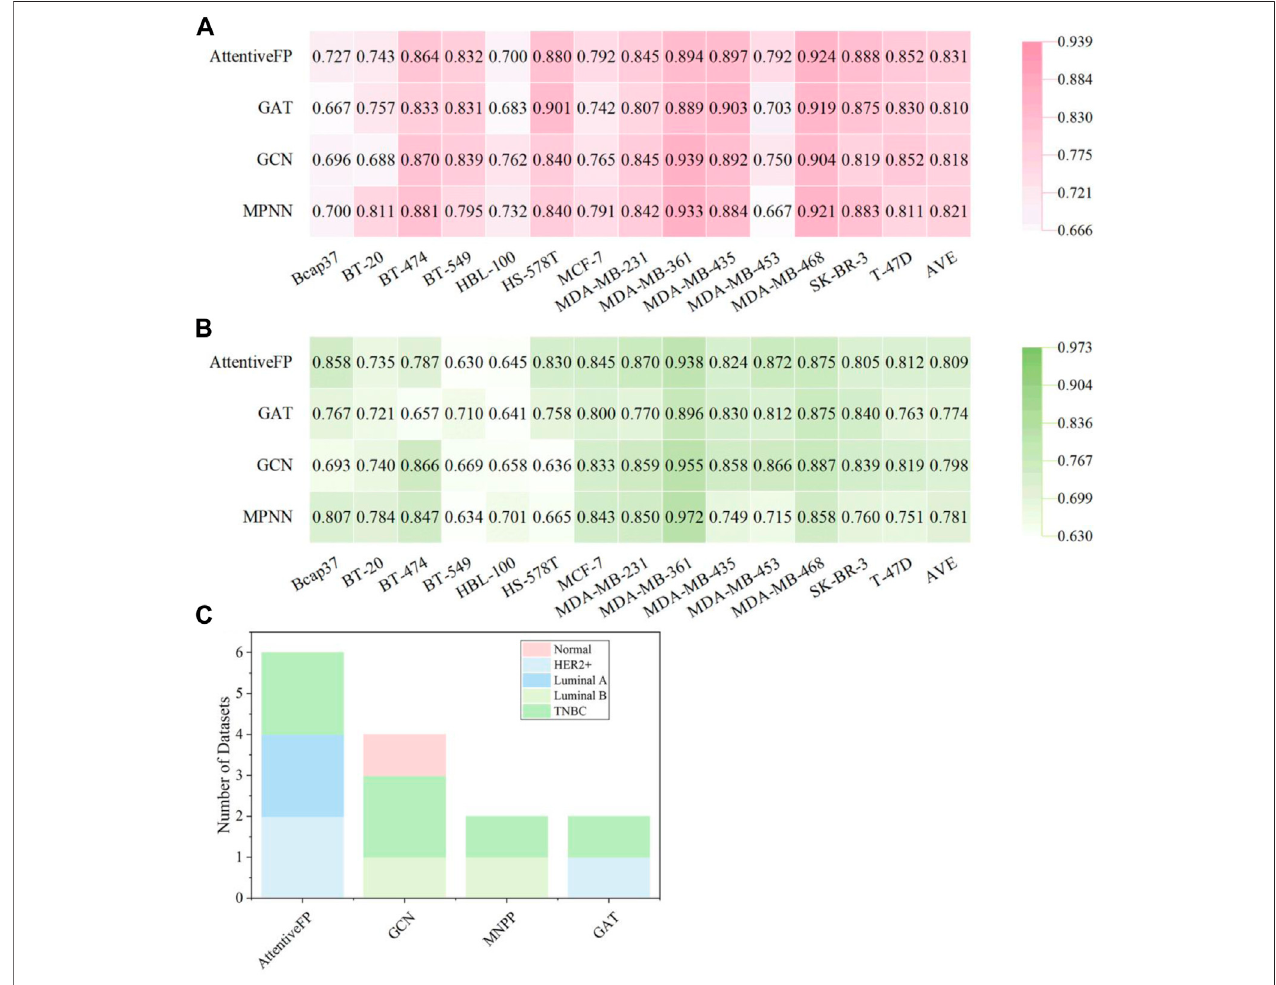
FIGURE 6 | Performance of graph-based BC prediction models. (A) F1 scores of graph-based models. (B) AUC results of graph-based models. (C) The optimal models based on molecular graph for different subtypes of breast cell lines.